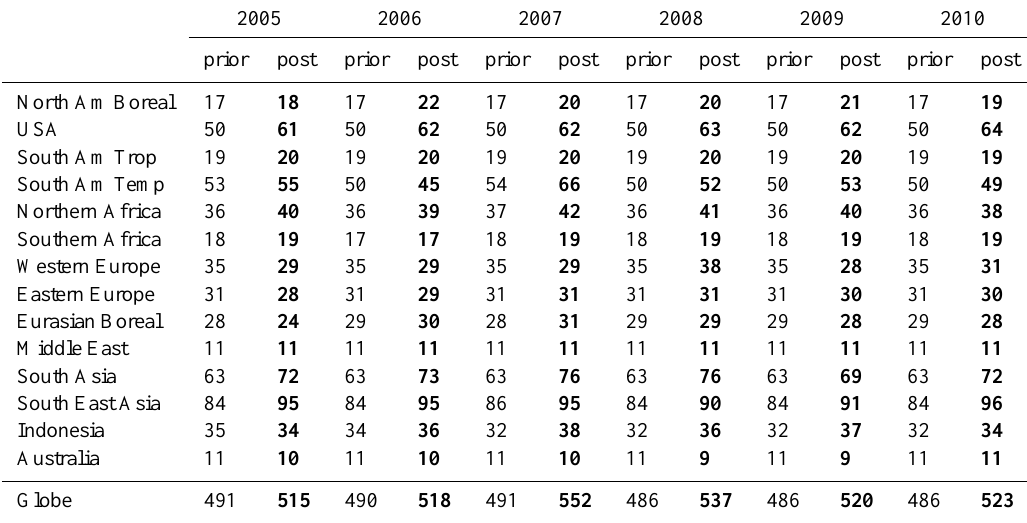
Table 5. Total CH 4 emissions for years 2005 to 2010, before inversion and after inversion , for 14 continental regions and for the globe in TgCH 4 yr − 1 . All budgets correspond to a 12-month